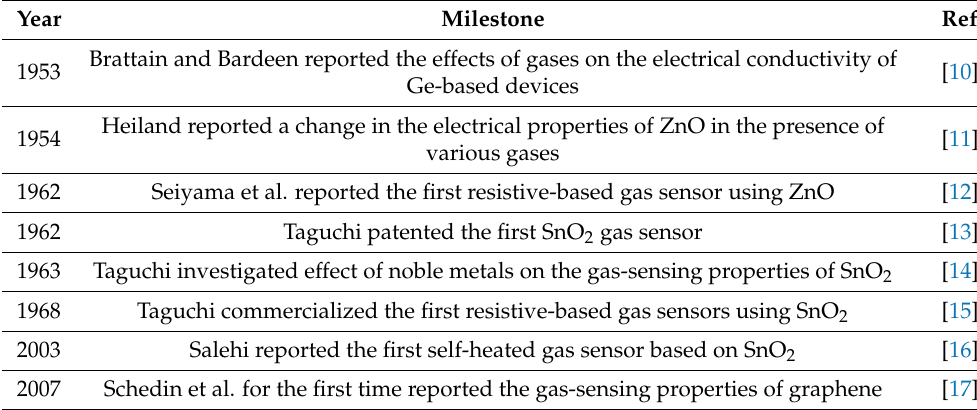
Table 1. Milestones in history of resistive-based gas